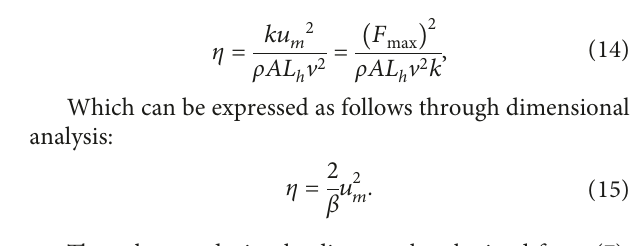
Figure 4: Results of the motion response of the bit for m r (cid:31) 1. (a) All cases. (b) Case 1. (c) Case 2. (d) Case 3. (e) Case 4. (f) Case 5. (g) Case